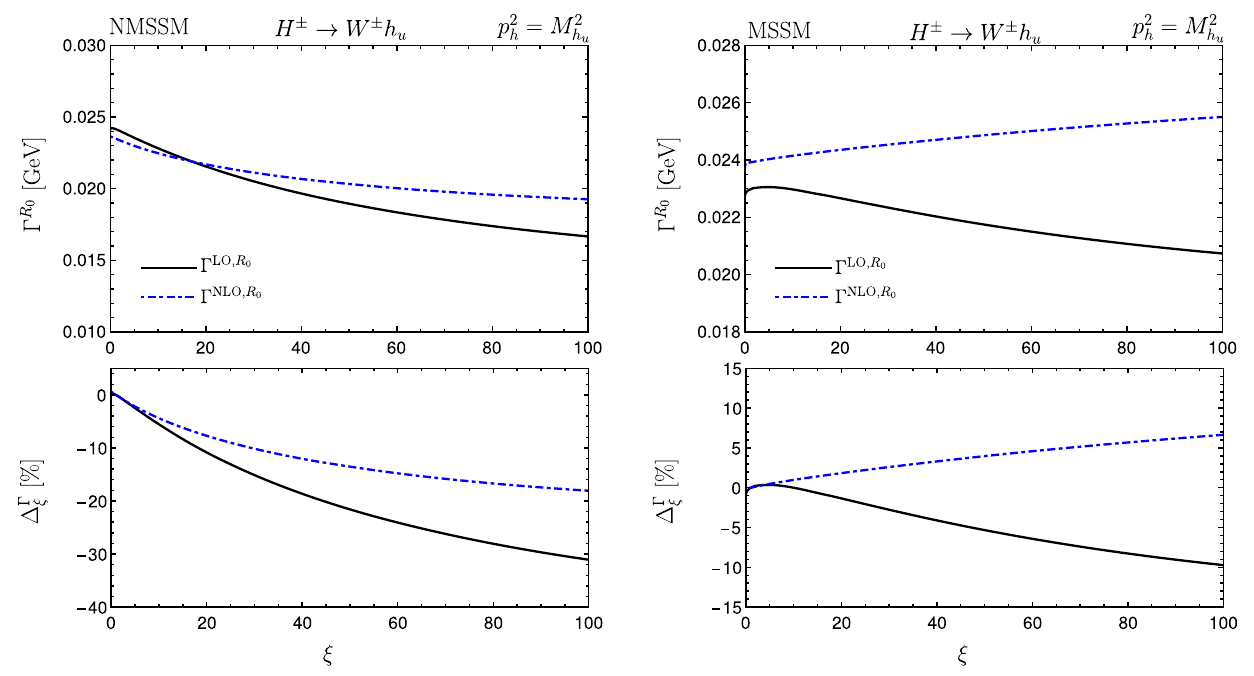
Fig. 11 Analogous to Fig. 10, but using the R 0 -method instead of the iterative approach to extract the loop-corrected masses and mixing matrix